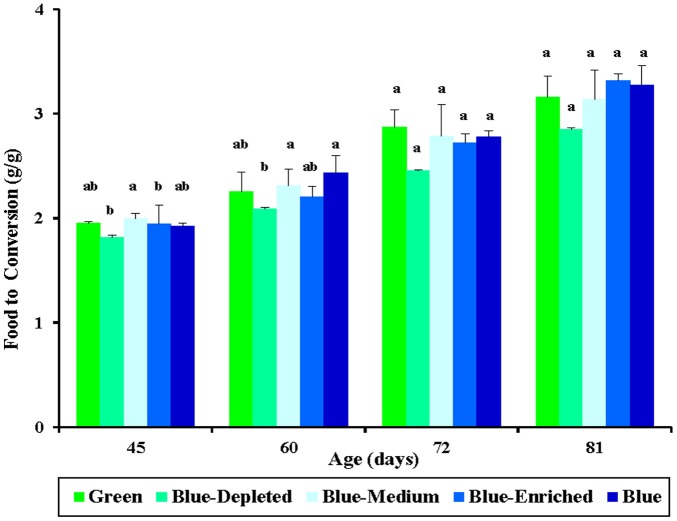
Feed conversion (g/g) of chickens reared under different polychromatic light spectra.Cumulative food consumption and body mass was measured to calculate the food conversion. Feed conversion = (final period body mass – initial period body mass)/period food consumption. Data are expressed as the mean value ± SEM (n = 20). Bars marked with different letters are significantly different from each other (P<0.05).